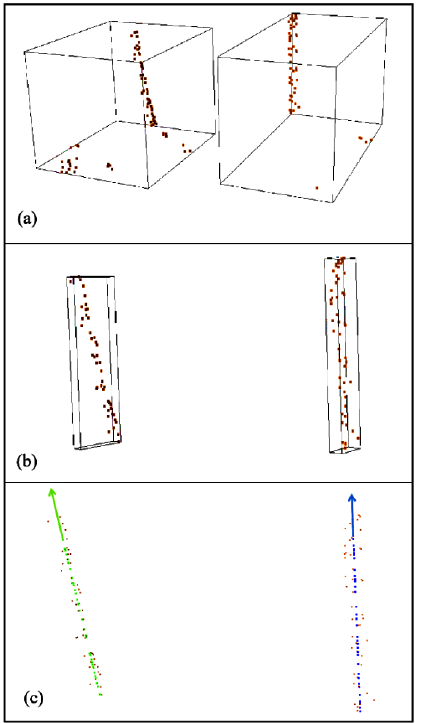
Figure 5. (a) The results of clustering with OPTICs algorithm, (b) the final trunks and (c) trunk direction of two neighbouring trees